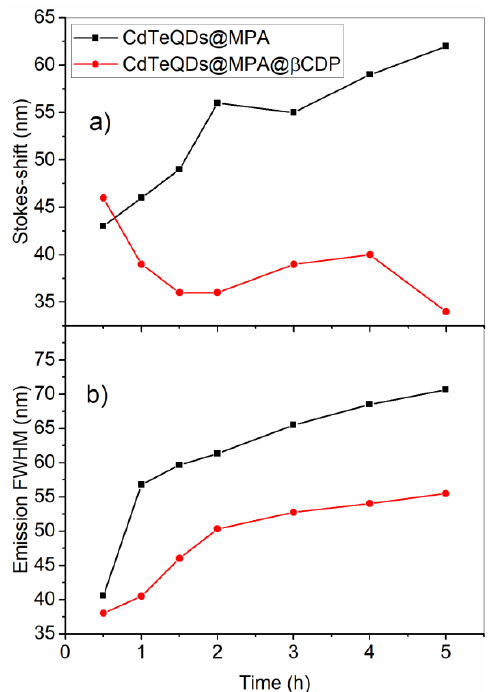
Figure 3. Graphs of Stokes-shift ( a ) and Full Width at Half Maximum (FWHM) ( b ) at different reaction time in the absence (squares) and presence (circles) of βCDP.